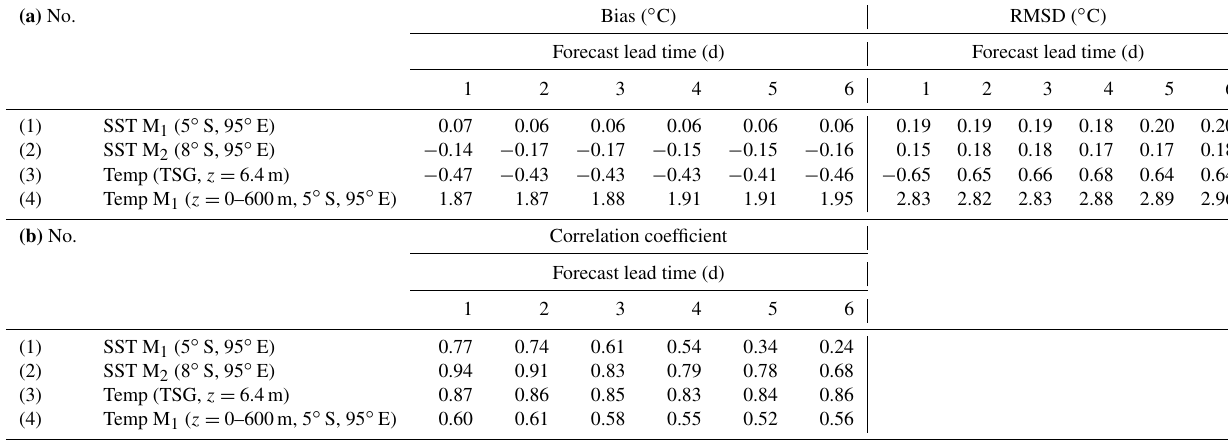
Table 5. Items (1) and (2) are a summary of SST bias and RMSD (a) and correlation coefficient (b) statistics between coupled ocean forecasts and observations at the mooring locations M 1 (5 ◦ S, 95 ◦ E) and M 2 (8 ◦ S, 95 ◦ E) during October 2019. Hourly averaged temperature from the model and observations is used for the analysis. Item (3) is the same as items (1) and (2) but for temperatures at 6.4m depth along the track shown in Fig. 3. Daily averaged temperature from model and instantaneous temperature at 12:00UTC from observation is used for the analysis. Item (4) is the same as items (1) and (2) but for temperatures within 0 to 600m depth at the mooring location M 1 . Daily averaged temperature model and observations used in the